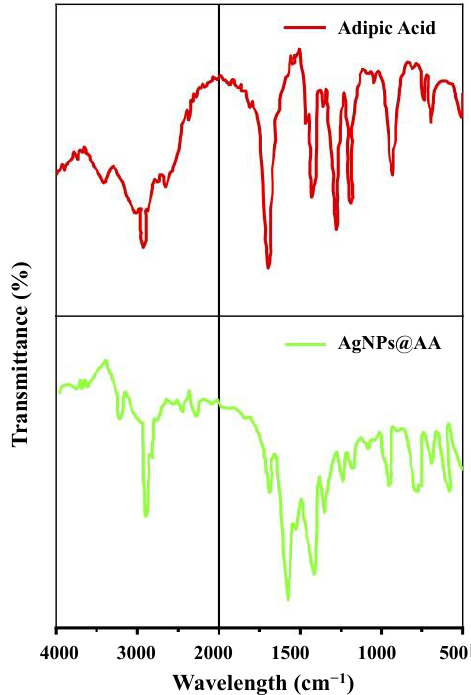
Figure 2. FTIR Spectra of adipic acid and AgNPs@AA.